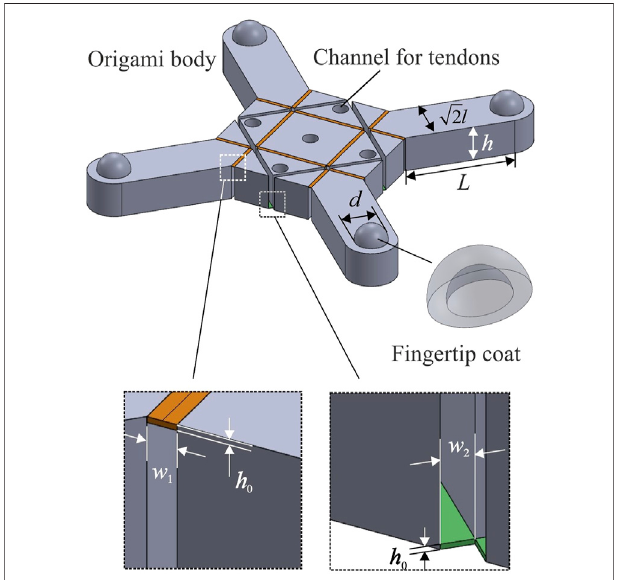
FIGURE 5 | CAD model of the origami body for 3D printing and a schematic view of the fi ngertip coat. Channels to accommodate tendons and detailed parameters of two folds are also denoted. Note that tiny points with a radius of 0.1 mm were added to the fi ngertip coat to increase friction before sending it for